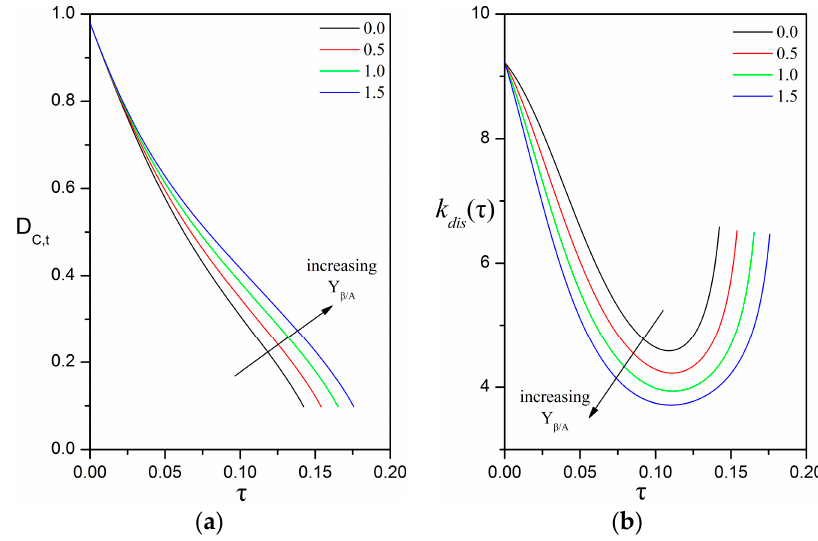
Figure 9. Impact of the biofilm yield coefficient Y β / A on the temporal evolution of: ( a ) the dimless diameter of the oily core; and ( b ) the dimless dissolution rate; for H A , υ / β = 1.0; Λ A β = 0.1. The other parameters are: Pe υ ,0 = 100; δ β ,0 = 0.02; h T = 6; Da υ = 0; k srn = 0; velocity mode = “const.